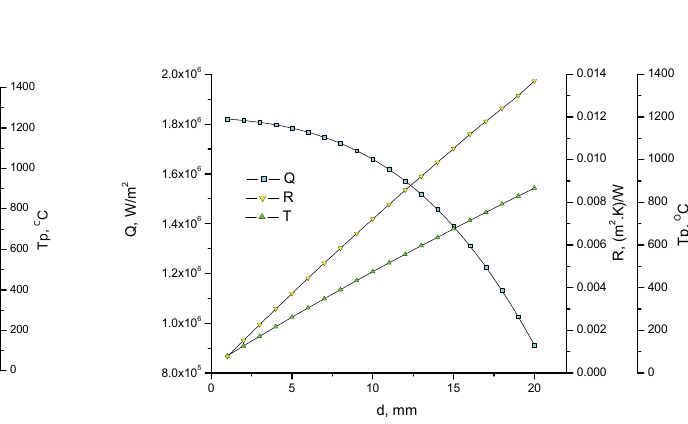
Figure 5: Heat losses, surfaces temperature and thermal resistance of insulation as a function of chromite insulation thickness.